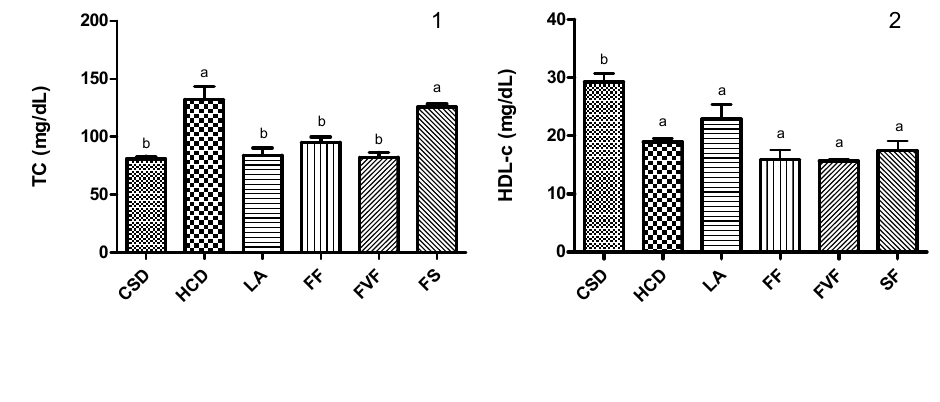
Figure 1. Plasma lipid concentrations from rats fed a CSD (control standard diet), HCD (high-cholesterol diet), and groups fed HCD plus LA (500 mg lyophilized asparagus/kg), FF (500 mg fiber fraction/kg), FVF (50 mg flavonoid fraction/kg) and SF (5 mg saponin fraction/kg) for five weeks. Effects on ( 1 ) total cholesterol (TC); ( 2 ) high-density lipoprotein cholesterol (HDL-c); ( 3 ) low-density lipoprotein cholesterol (LDL-c); ( 4 ) triglycerides (TG) and ( 5 ) atherogenic index (AI) calculated as